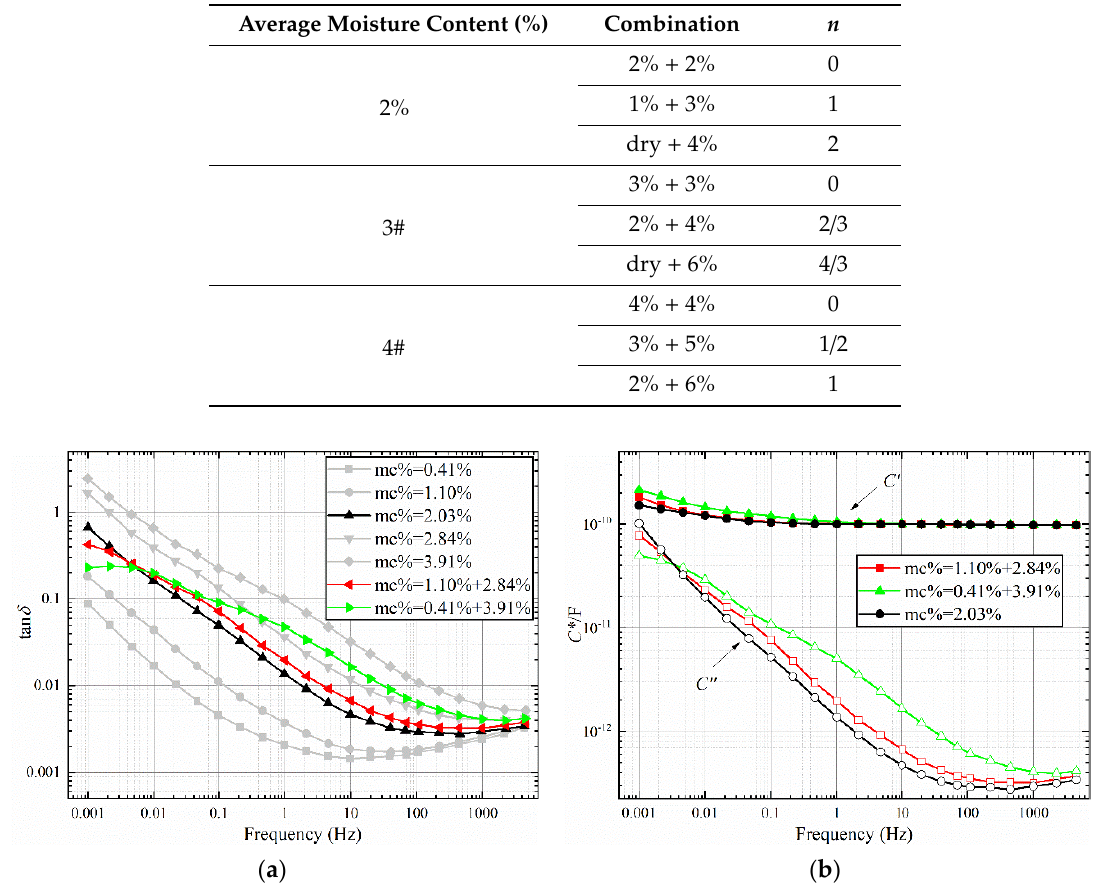
( a ) ( b ) Figure 8. FDS characteristic curve with an average water content of 4%. ( a ) tan δ - f , ( b ) C *- f . 3.2. Bushing Model 3.2.1. Non-central Symmetric Distribution of Moisture The dielectric response tester with the amplifier is used to perform the FDS test on the bushing model. The FDS test frequency range is 1m Hz ~ 5k Hz; test temperature is 40 °C; peak test voltage